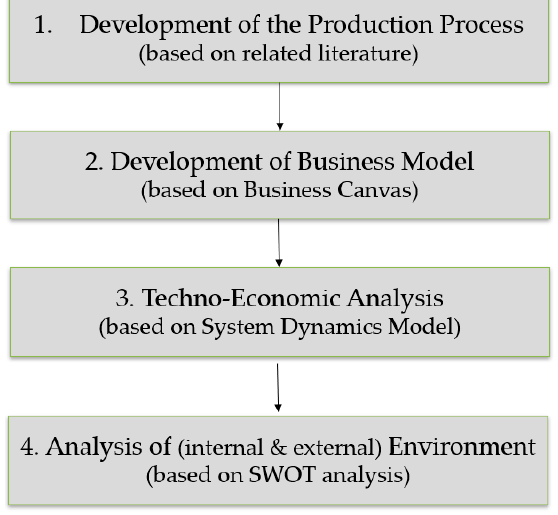
Figure 2. The 4-step framework of analysis. Table 2. Prefecture of Achaia: Data on OMWW supply and PHAs demand.